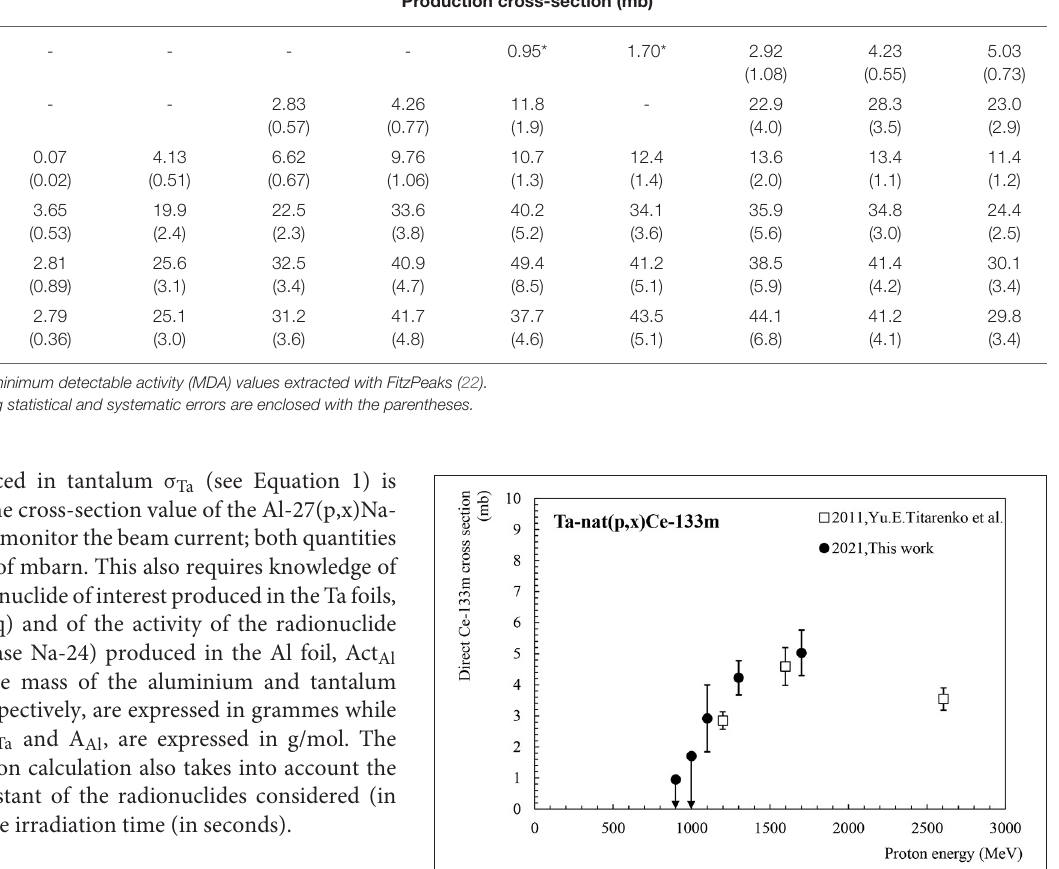
Equation 1: production cross-section calculation for the radionuclides produced in the Ta foils